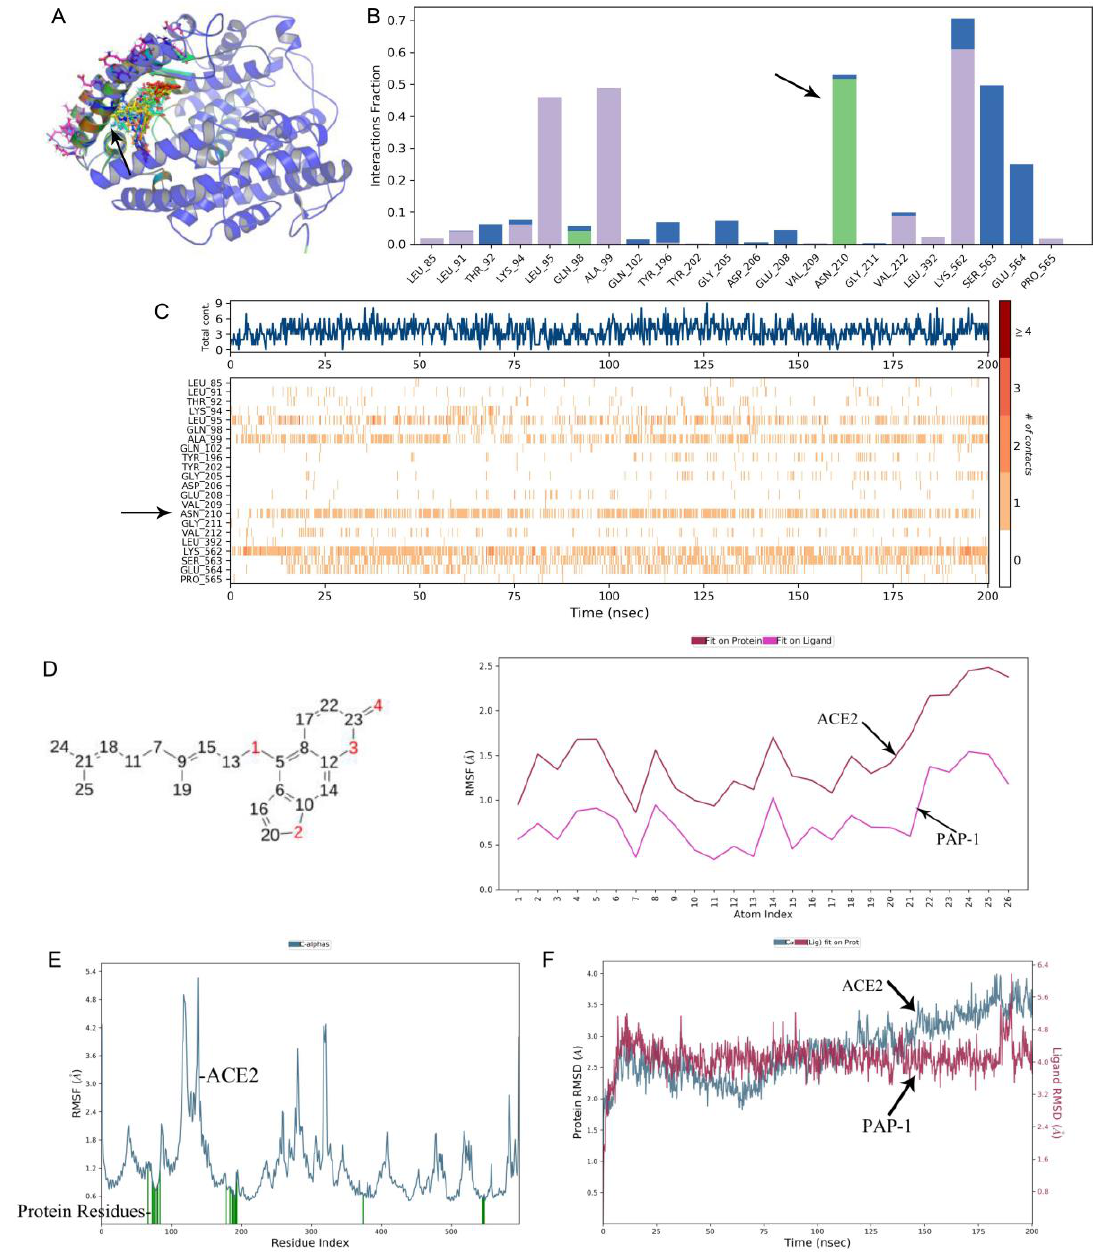
Figure 3. Molecular dynamic simulation analysis of PAP-1 and ACE2. ( A ) Molecular docking result mode. The black arrow shows the binding position of ACE2 protein with PAP-1. ( B ) Analysis of interaction between ACE2 protein residue and PAP-1. H-bonds (green part) play a significant role in ligand binding. The black arrow shows that the ACE2 protein has made more than one specific contact with the ASN210 residue in a hydrogen bond. ( C ) Contract number with protein residues. The black arrow shows ASN210 residues make more than one specific contact with the ligand, which are represented by a darker shade of orange, according to the scale to the right of the plot. ( D ) Drug action analysis of RMSF. The black arrow shows the internal atom fluctuations of the PAP-1 ( E ) ACE2 protein RMSF. The black arrow shows ACE2 protein residues that interact with the PAP-1 are marked with green-colored vertical bars. ( F ) The interaction of RMSD between ACE2 protein with PAP-1. The black arrow indicates that the observed ligand PAP-1 value is significantly less than the RMSD of protein, indicating that PAP-1 did not diffuse from its initial binding site.